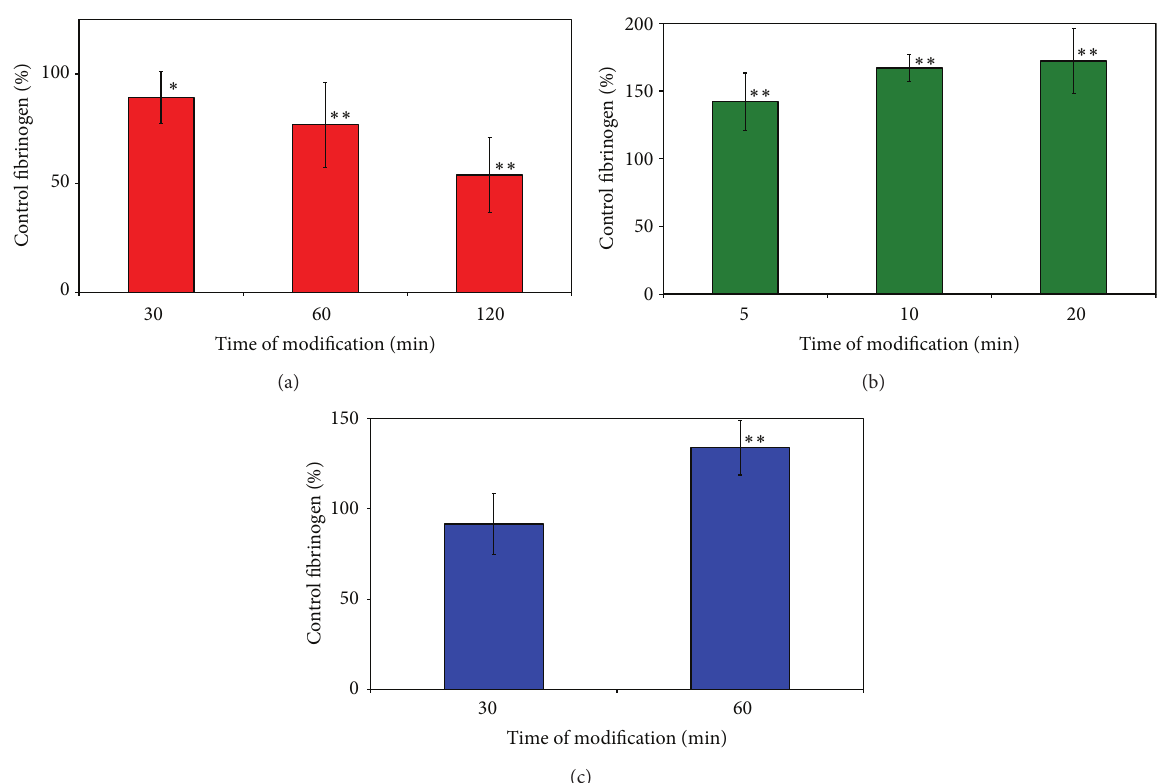
Figure 4: Dynamic adhesions (relative surface coverage) in the presence of control and modified fibrinogen. Fibrinogen (Fbg) modified by (a) MDA, (b) NaOCl, and (c) SIN-1. Data are expressed as a percentage of surface coverage in the presence of modified fibrinogens relatively to surface coverage in the presence of control fibrinogen. Results are represented as mean ± SD of nine values from three independent experiments (three values per experiment). Student’s 𝑡 -test probability: ∗ 𝑃 < 0.05 ; ∗∗ 𝑃 < 0.01